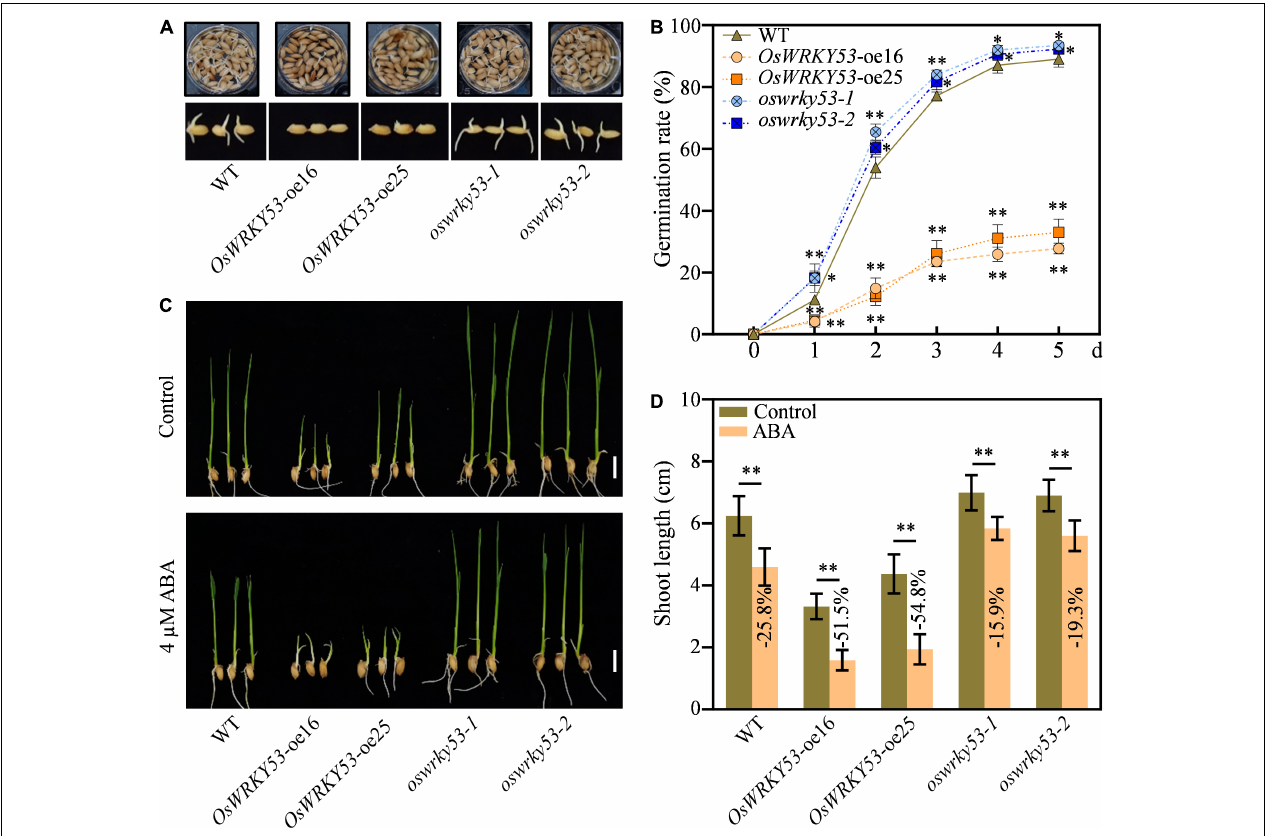
FIGURE 6 | Overexpression of OsWRKY53 inhibits seed germination and post-germination growth. (A) Phenotype of OsWRKY53 -oe, oswrky53 mutants, and wild type (WT) at 3 days after imbibition (DAI). (B) Seed germination rate of OsWRKY53 -oe, oswrky53 mutants, and WT under normal condition. The germination rate was counted every 24 h after imbibition. (C) Phenotype of seedlings of OsWRKY53 -oe, oswrky53 mutants, and WT at 10 DAI under 4 µ M ABA treatment with water as a control. Scale bar = 1 cm. (D) Shoot length of OsWRKY53 -oe, oswrky53 mutants, and WT at 10 DAI under 4 µ M ABA treatment with water as a control. Data represent mean ± SD. Asterisks indicate a significant difference between transgenic lines and WT determined by two-tailed Student’s t -test at ∗∗ p < 0.01 or ∗ p < 0.05.